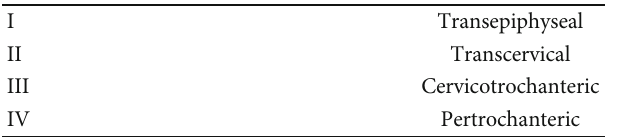
Table 1: Delbet and Colonna classi fi cation of capital femoral epiphyseal injuries, after Colonna, 1928 – 1929 [5,